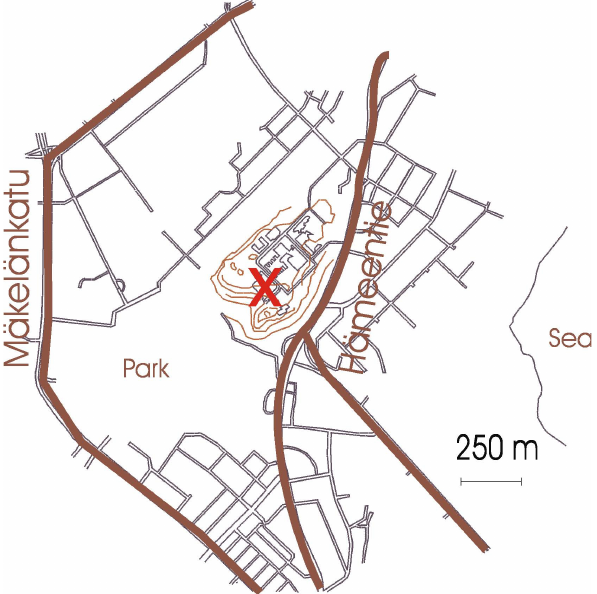
Fig. 1. Location of the sampling site in Kumpula, Helsinki. Thick lines are major roads. The minimum distance from the H¨ameenkatu road to the sampling site is 250m. Distance to M¨akel¨ankatu is